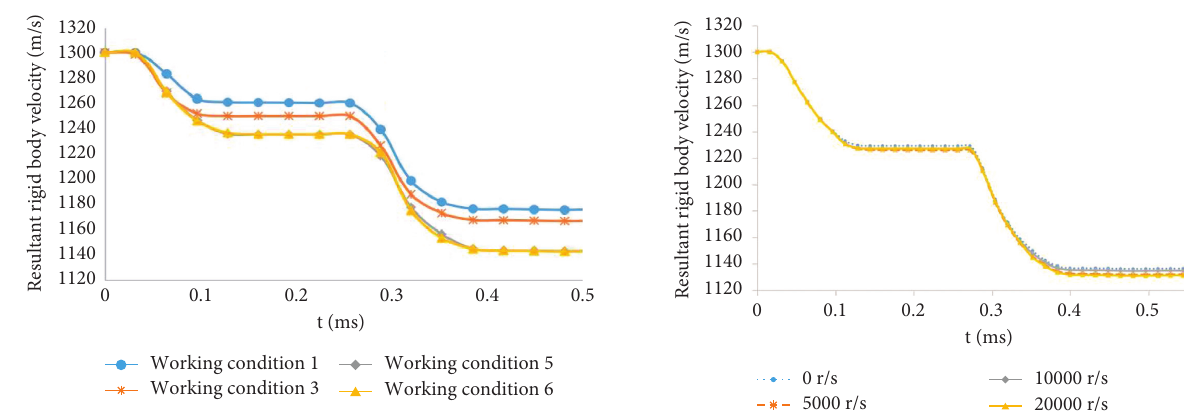
Figure 6: The change of projectile speed.